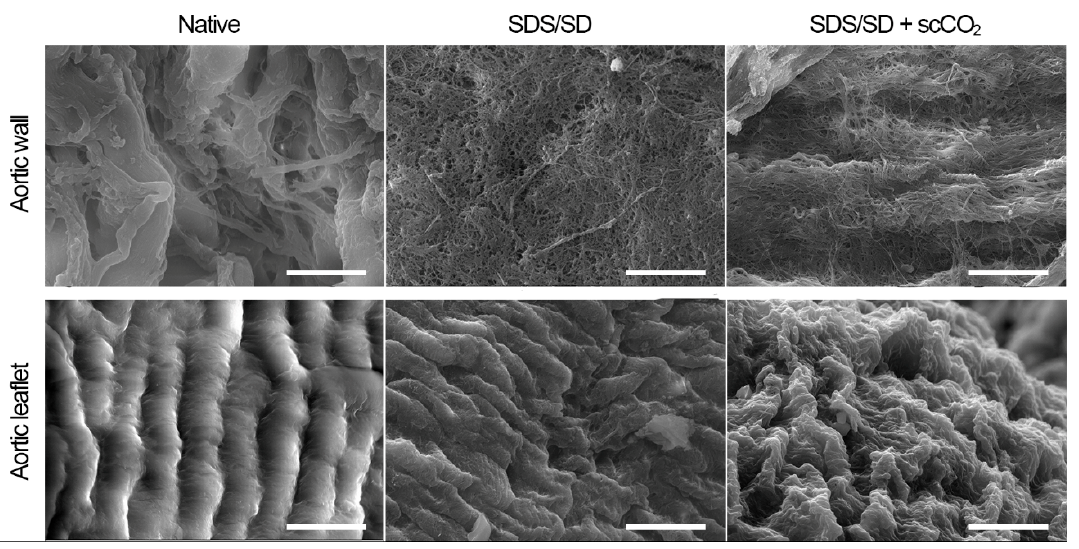
Figure 5. Scanning electron microscopy of ovine aortic roots decellularized in a 0.5% SDS / 0.5% SD detergent solution (SDS / SD) and after the subsequent processing in scCO 2 medium (T = 37 ◦ C, P = 25 MPa, t = 3 h). Scale bar = 10 µm.